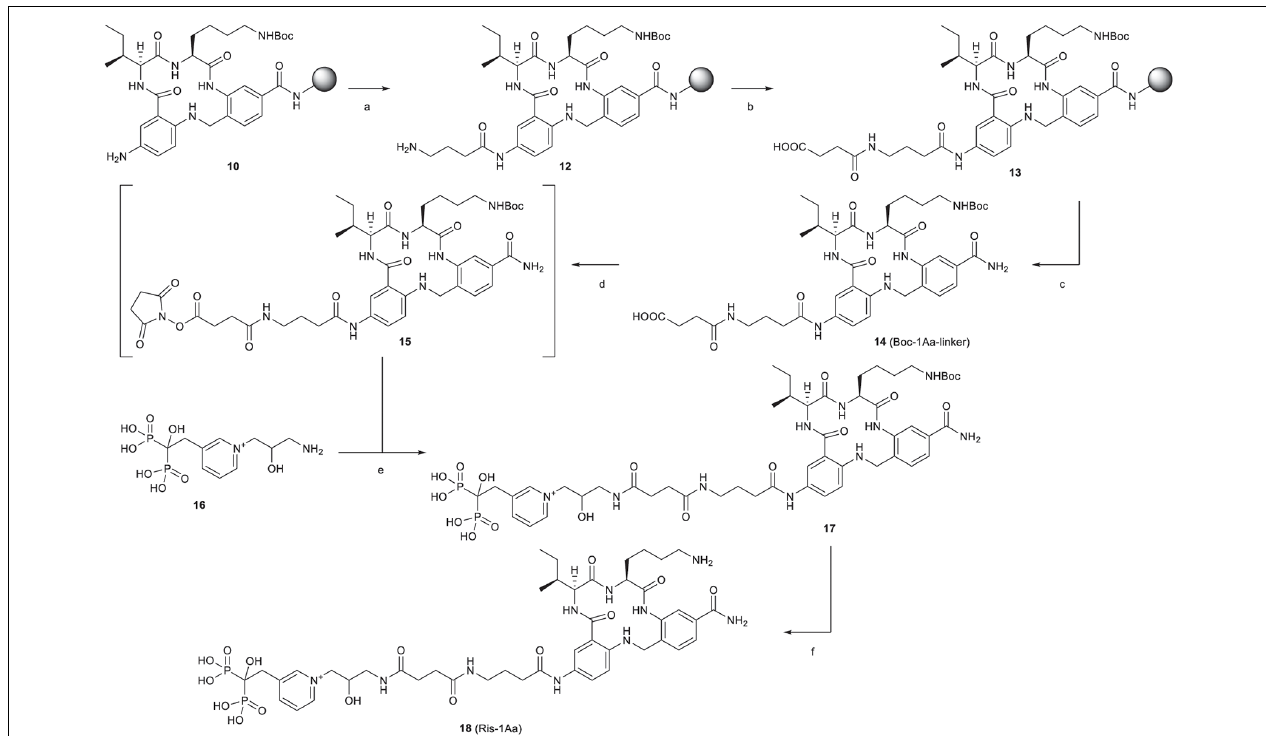
FIGURE 2 | Synthesis of Ris-1Aa. Reagents and conditions: (A) (1) Fmoc-GABA-OH, HBTU, DIEA, DMF, 15 h (2) 20% piperidine in DMF; (B) succinic anhydride, DMF, 25 h; (C) (1) 1:1:18 H 2 O/TIS/TFA, 3 h; (2) Boc 2 O, TEA, 1:2 DMF/MeOH, 22 h, 20% over 14 steps; (D) TSTU, TEA, DMF, r.t., 2 h; (E) NaHCO 3 , 2:3 DMF/H 2 O, pH 8.3, 19 h, 52% over 2 steps; (F) 1:2 TFA/H 2 O, 3 h, 57%.